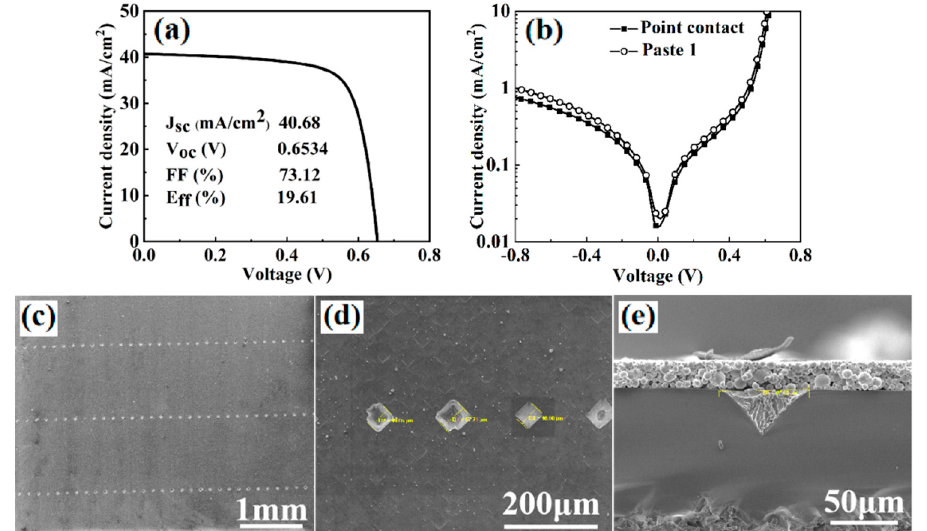
Figure 12. ( a ) Light J-V curve of a solar cell with point contact; ( b ) dark J-V curves of the cells obtained with point contact by using paste 1; ( c , d ) SEM surface images of point contact cell and ( e ) cross-sectional SEM image obtained on one-dot contact.